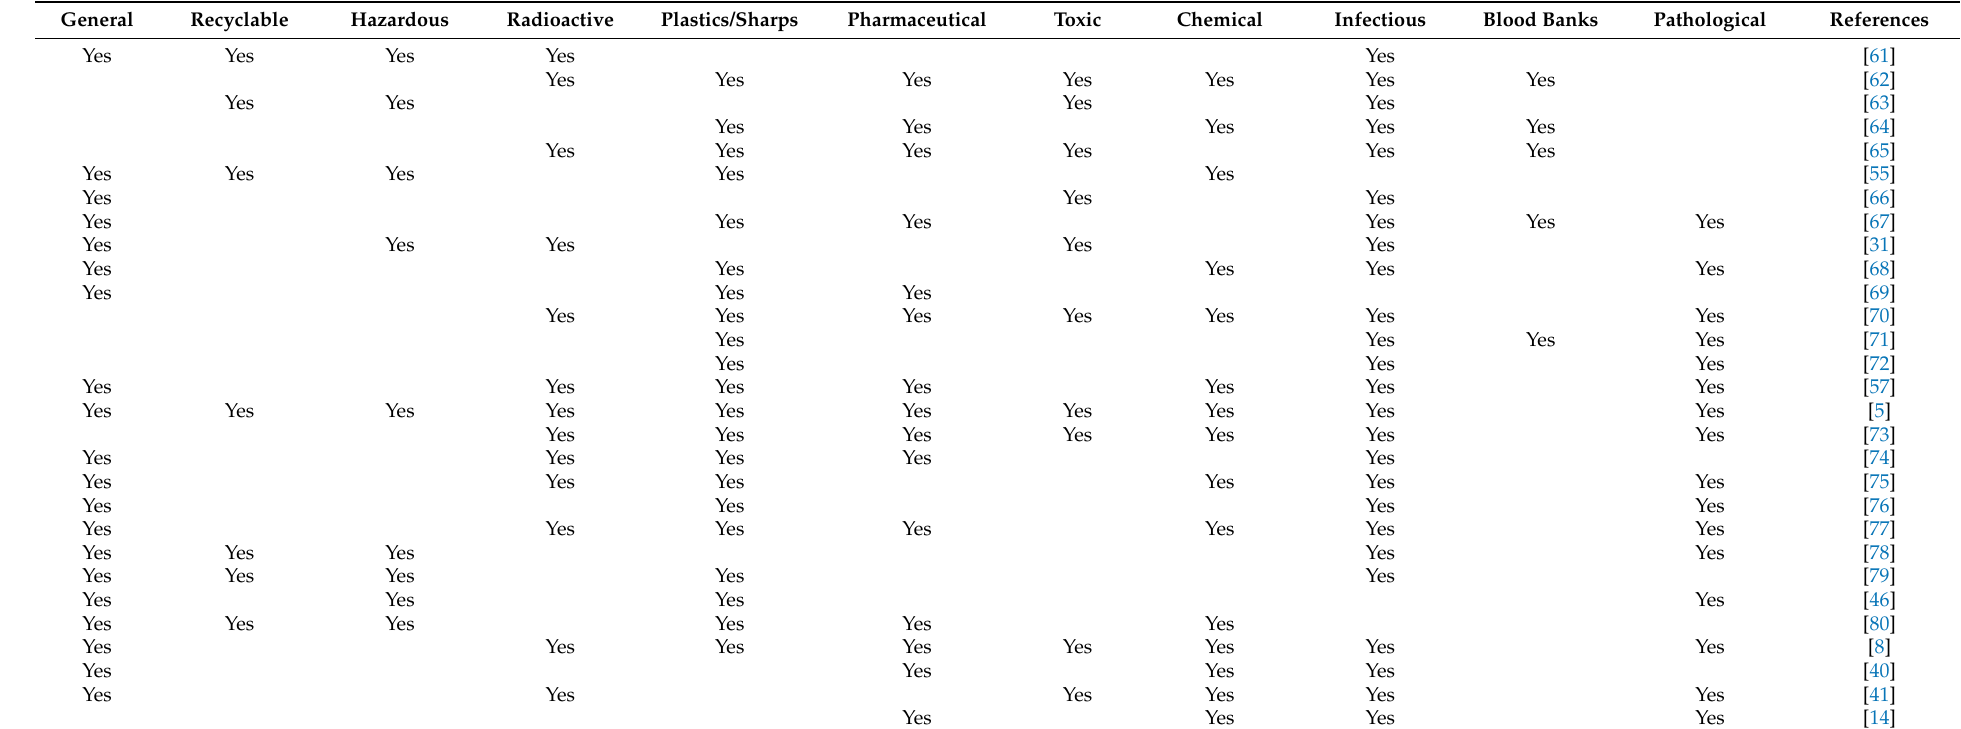
Table 2. Medical waste